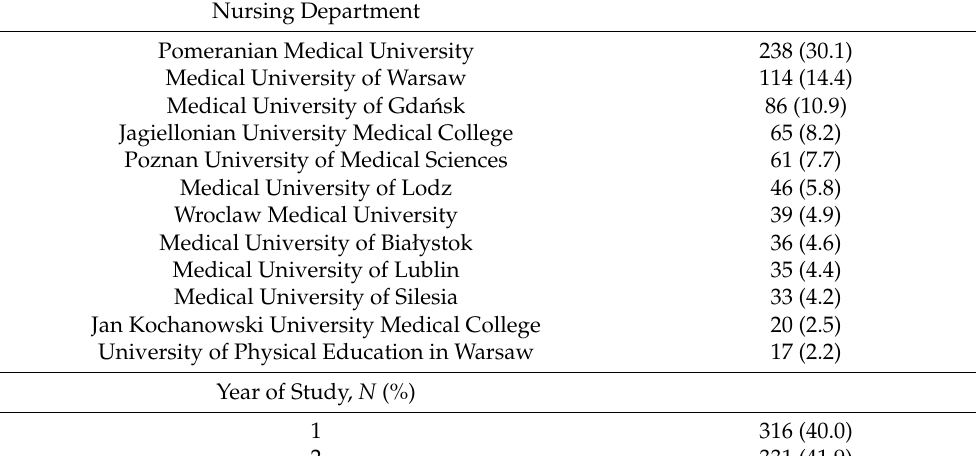
Table 1. Characteristics of study group ( N =